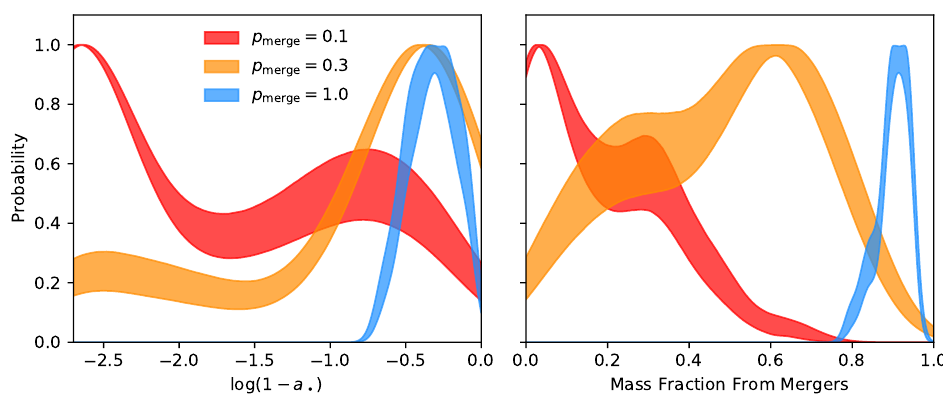
Figure 6. Distributions of spin (cast in terms of log ( 1 − a • ) ) and mass fraction accumulated via mergers for SMBHs in 10 15 M (cid:12) halos using a semi-analytic model. In the left panel, we see that models which allow more mergers produce SMBHs with less extreme spin values. In the right panel, we see that most SMBH mass can originate from mergers if all of them are allowed to